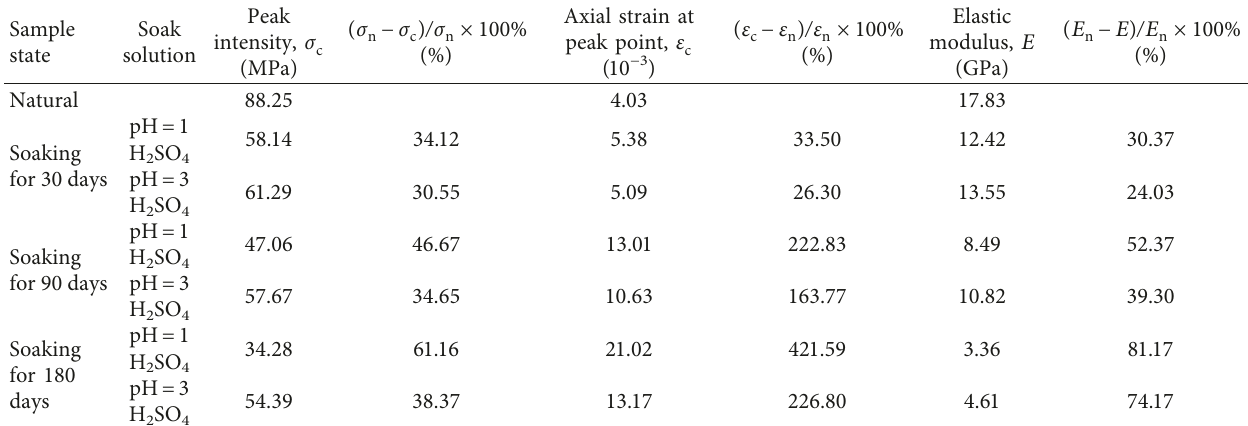
Figure 7: Experimental phenomenon of the samples in different pH solutions after soaking for 15 days. Table 4: Uniaxial compressive test results of the sandstone samples subjected to acid